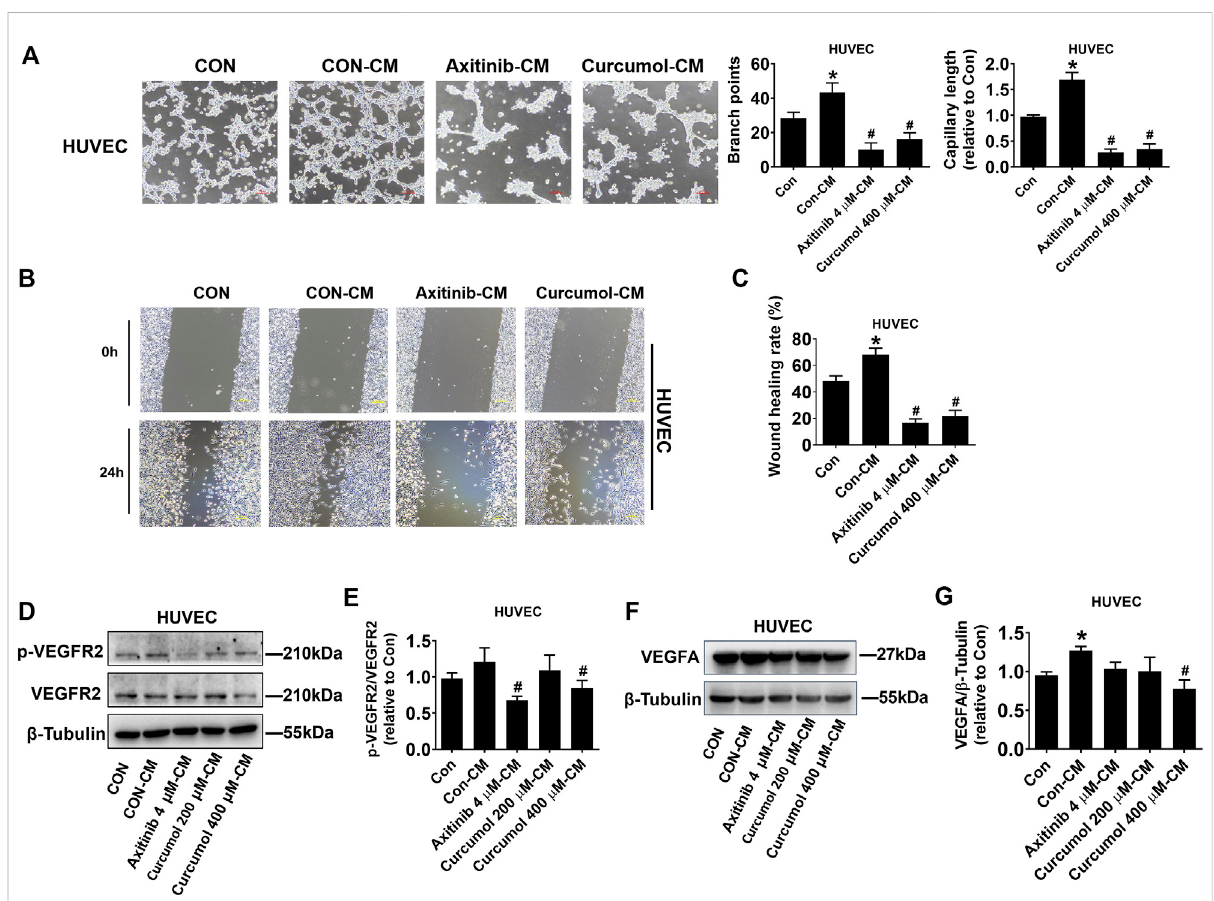
FIGURE 2 Effect of A549 cell-derived CM on HUVEC angiogenesis. HUVECs were cultured with CM derived from A549 for 24 h, then a series of assays, including (A) tube formation (Scale bar, 100 μ m), (B , C) wound healing (Scale bar, 200 μ m), (D – G) Western blot,wereperformed to investigateeffect ofCurcumolonendothelialcellsintumormicroenvironment.CM,conditionedmedium.HUVEC,humanumbilicalveinendothelialcell.Thedataare presented from fi ve independent experiments (n = 5) run in triplicate. * p < 0.05, compared with control (Con). # p < 0.05, compared with